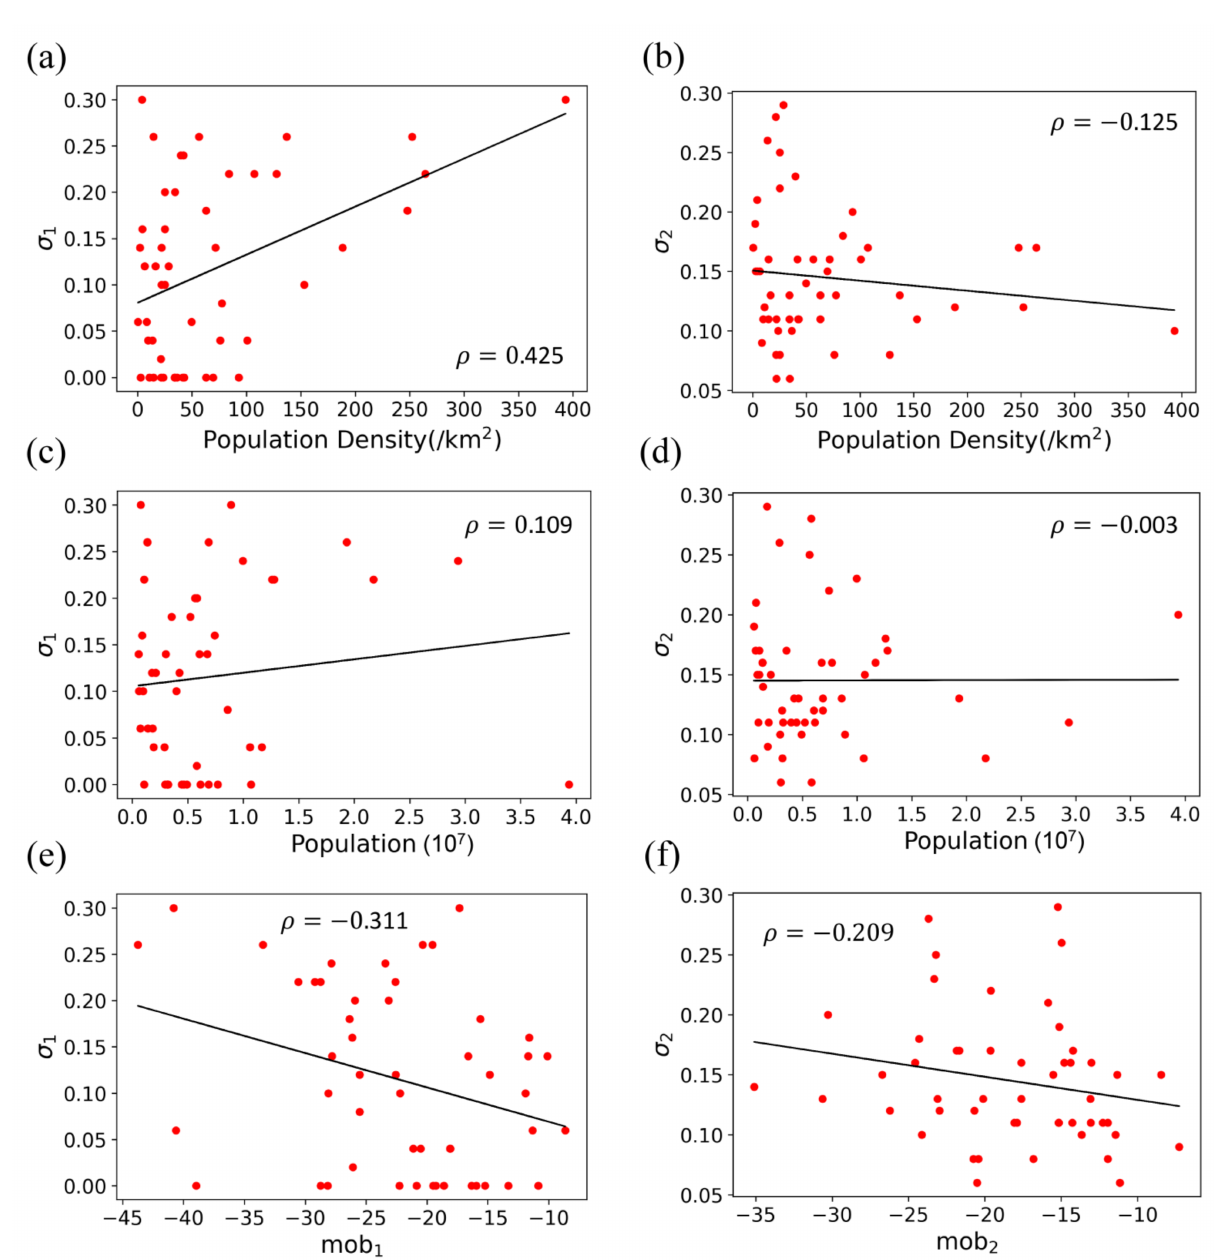
Figure 5. The intervention parameter σ vs. population density ( a , b ), population ( c , d ), and social mobility ( e , f ) for the 50 states in the US for the first and second outbreaks, respectively. The solid lines are the linear fittings of the data and the corresponding correlation coefficients are also